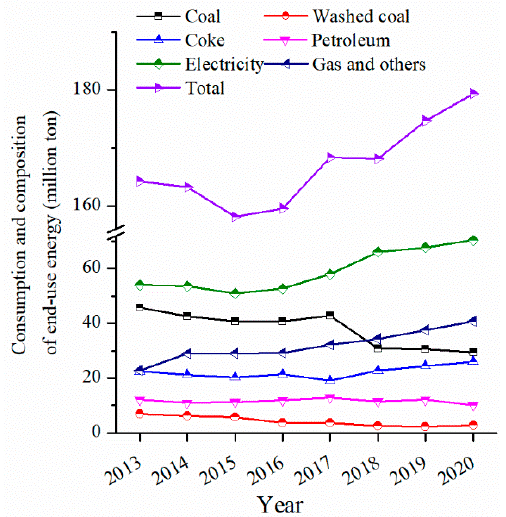
Figure 6. The composition of energy consumption in recent years in Shanxi Province, China. Air quality has improved significantly, owing to a series of strict control policies in China. The number of days that reached the air quality standards gradually increased, while the average annual PM 2.5 level gradually decreased. As shown in Figure 7 (the orig- inal data are listed in Table S4), from 2014 to 2020, in Jinzhong, Shanxi Province, China, the number of days that reached the air quality standards increased from 241 to 267 days, while the annual mean concentrations of PM 2.5 decreased from 64 to 42 μ g·m − 3 . These re- sults indicate that Shanxi’s energy transformation has achieved initial effects and will con- tinue to control coal consumption and further increase the use of clean energy to win the battle for a blue sky in the future.